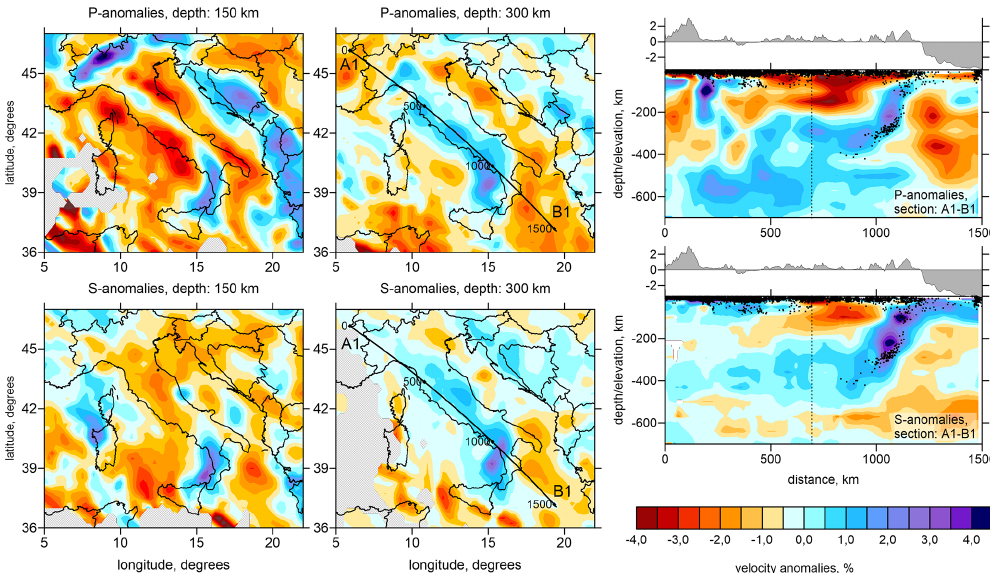
Figure 5. Inversion results with the use of smaller damping. Two horizontal and one vertical sections are shown for the P and S models. Indications are the same as in Figs. 3 and